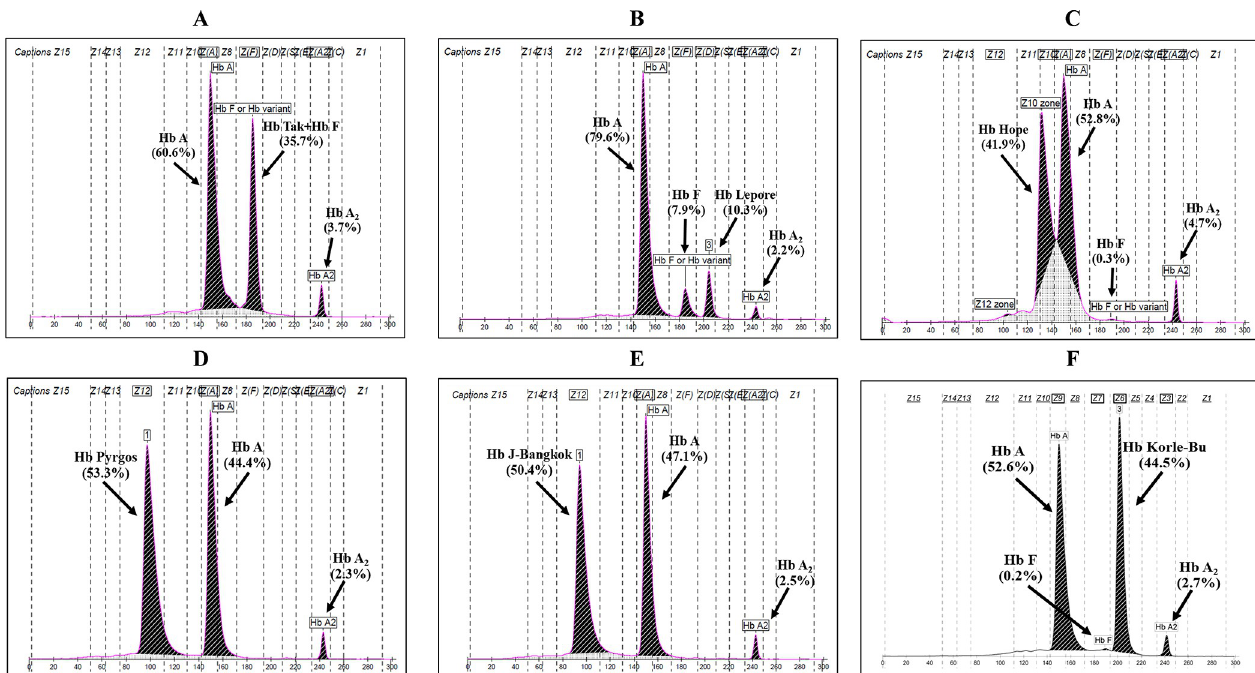
Fig 2. Representative Hb analysis by capillary electrophoresis of various abnormal Hbs encountered in the unnecessary PND group, including carriers of Hb Tak ( A ), Hb Lepore ( B ), Hb Hope ( C ), Hb Pyrgos ( D ), Hb J-Bangkok ( E ), and Hb Korle Bu ( F ). Normal and abnormal Hbs are indicated.